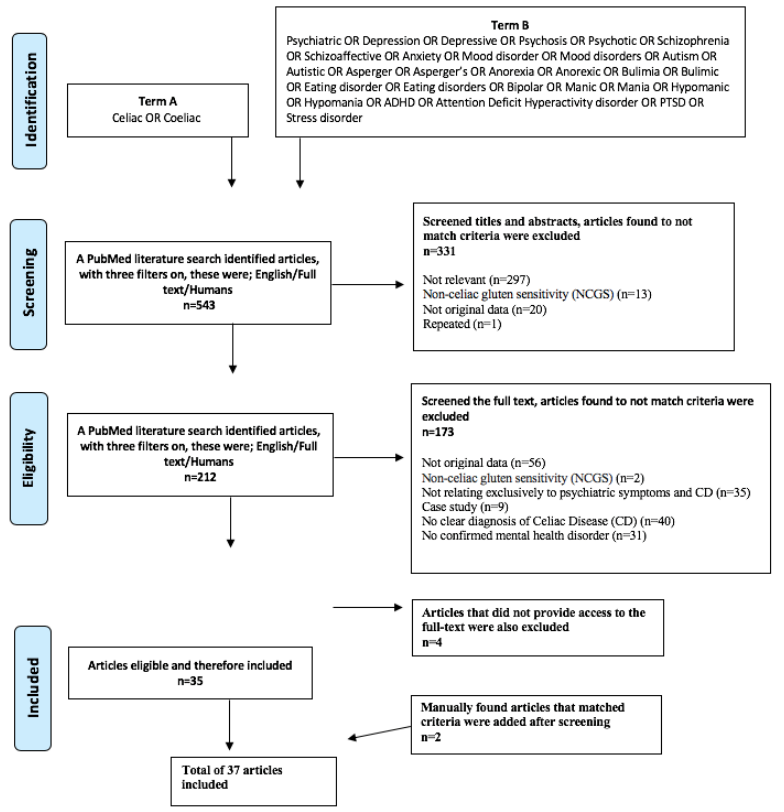
Figure 1. PRISMA flow chart displaying this selection process.